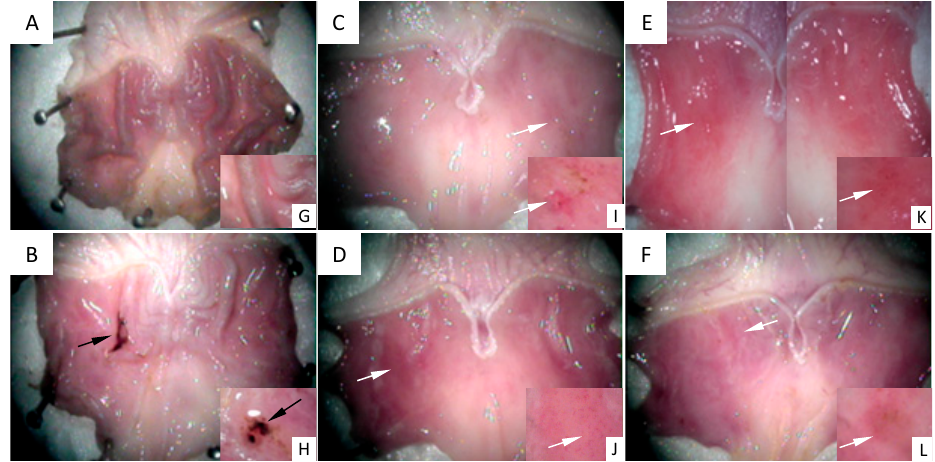
Figure 2. Images of the stomachs’ inner surface are seen under a stereoscopic magnifying glass. ( A ) control group (( G ) details of gastric roughness); ( B ) 48/80 group (( H ) details of gastric ulcer); ( C ) DhL + 48/80 group; ( D ) Xt + 48/80 group; ( E ) But + 48/80 group; ( F ) Crgl + 48/80 group (( I – L ) details of mild hyperemia). Black arrows: gastric ulcer. White arrows: mild hyperemia.